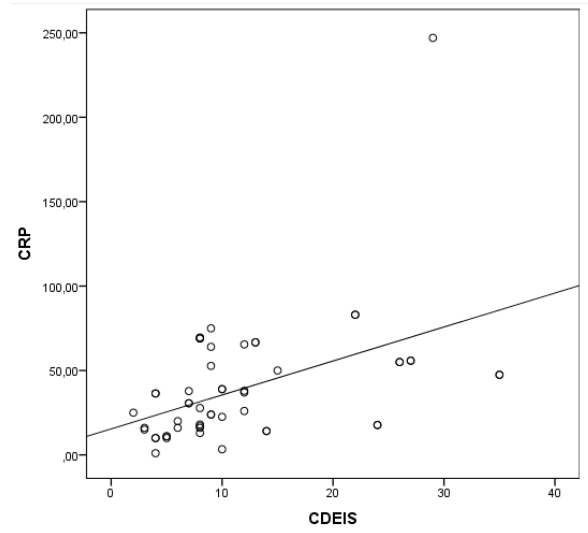
Figure 6B: Correlation between CRP and Crohn’s Disease Endosco- pic Index of